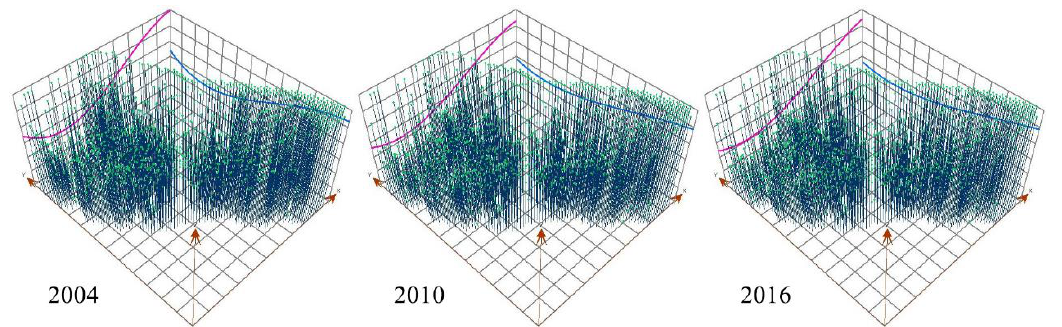
Figure 4. The trend surface of the ESEV in the study area (the horizontal axis (X-axis) on the plane indicates the west – east direction of the map, the vertical axis (Y-axis) on the plane indicates the south – north direction of the map, and the value on the vertical axis (Z-axis) of the cube represents the ESD value).